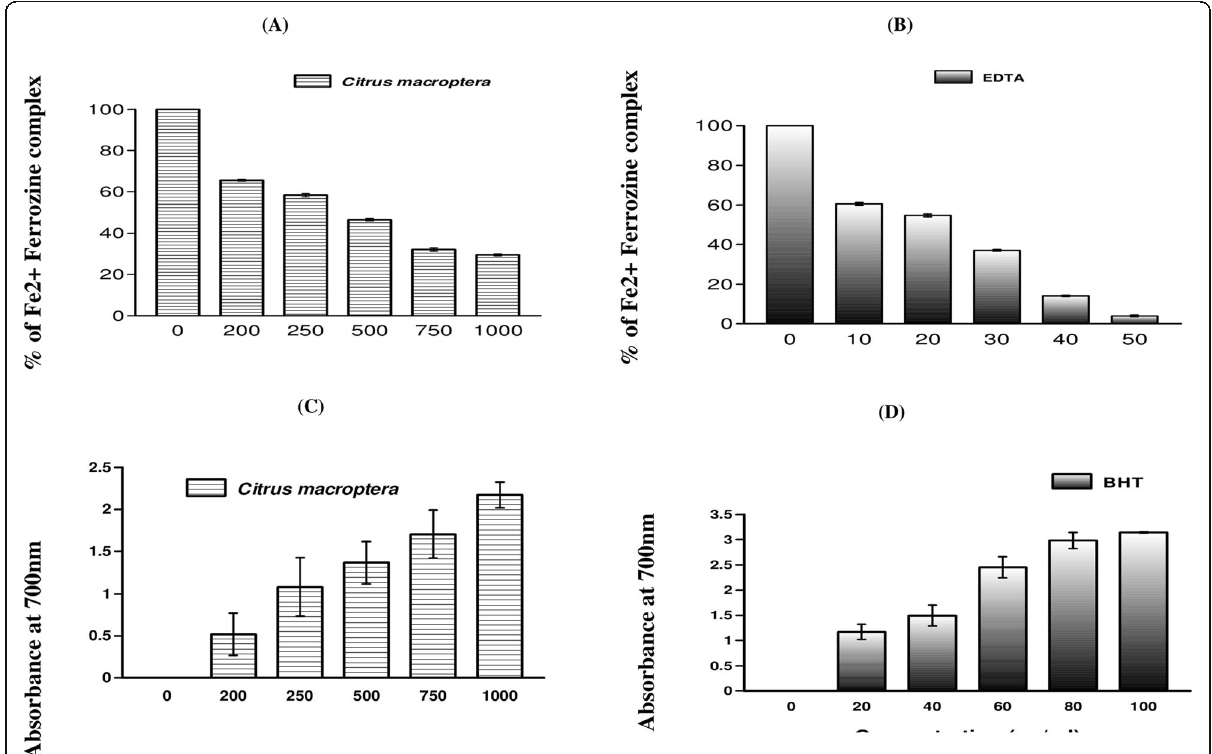
Fig. 2 Antioxidant activity of CML extract. a Iron chelating activity vs standard EDTA, b depicts reaming unneutralized Fe 2+ , c reducing power activity of CML, and d reducing activity of standard BHT where α = p < 0.05, Β = p < 0.01, γ = p < 0.001, and δ = non-significant when compared to